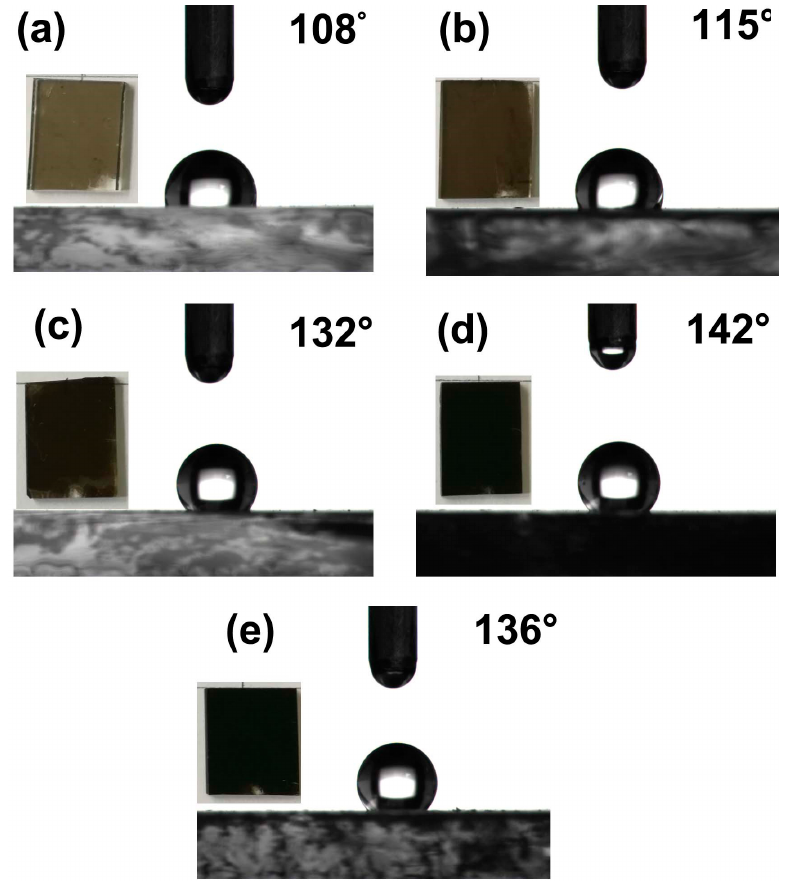
Figure 9. Contact angles: ( a ) the first-layer CS film; ( b ) the second-layer CS film; ( c ) the third-layer CS film; ( d ) the fourth-layer CS film; ( e ) the fifth-layer CS film.